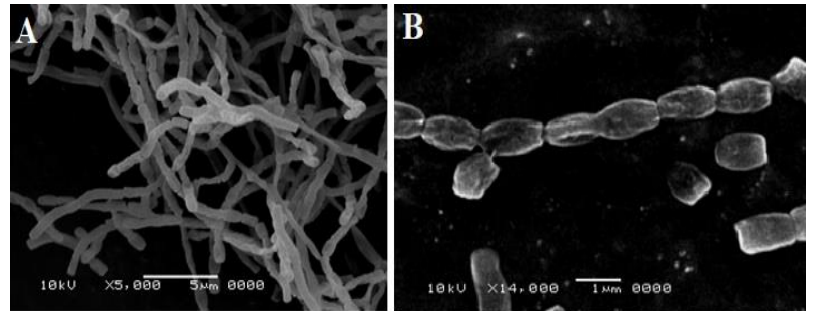
Figure 1. Microscopic examination of isolate DH7 using electron microscopy. Isolate DH7 was cultivated on starch casein media for 7 days at 30 °C. Aerial, substrate mycelium, and spores were examined using a scanning electron microscope: ( A ) magnification of the spore chain (×5000) and ( B ) magnification of the spores (×14,000).